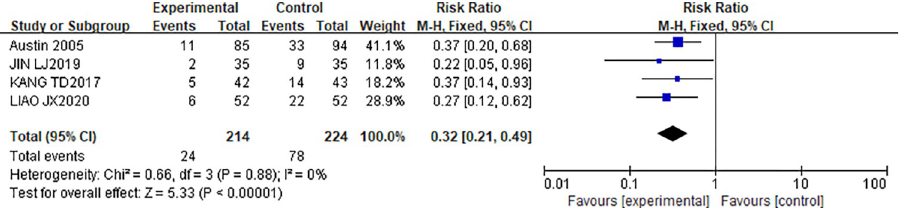
Fig 7. Influence of CR on Readmission rate of